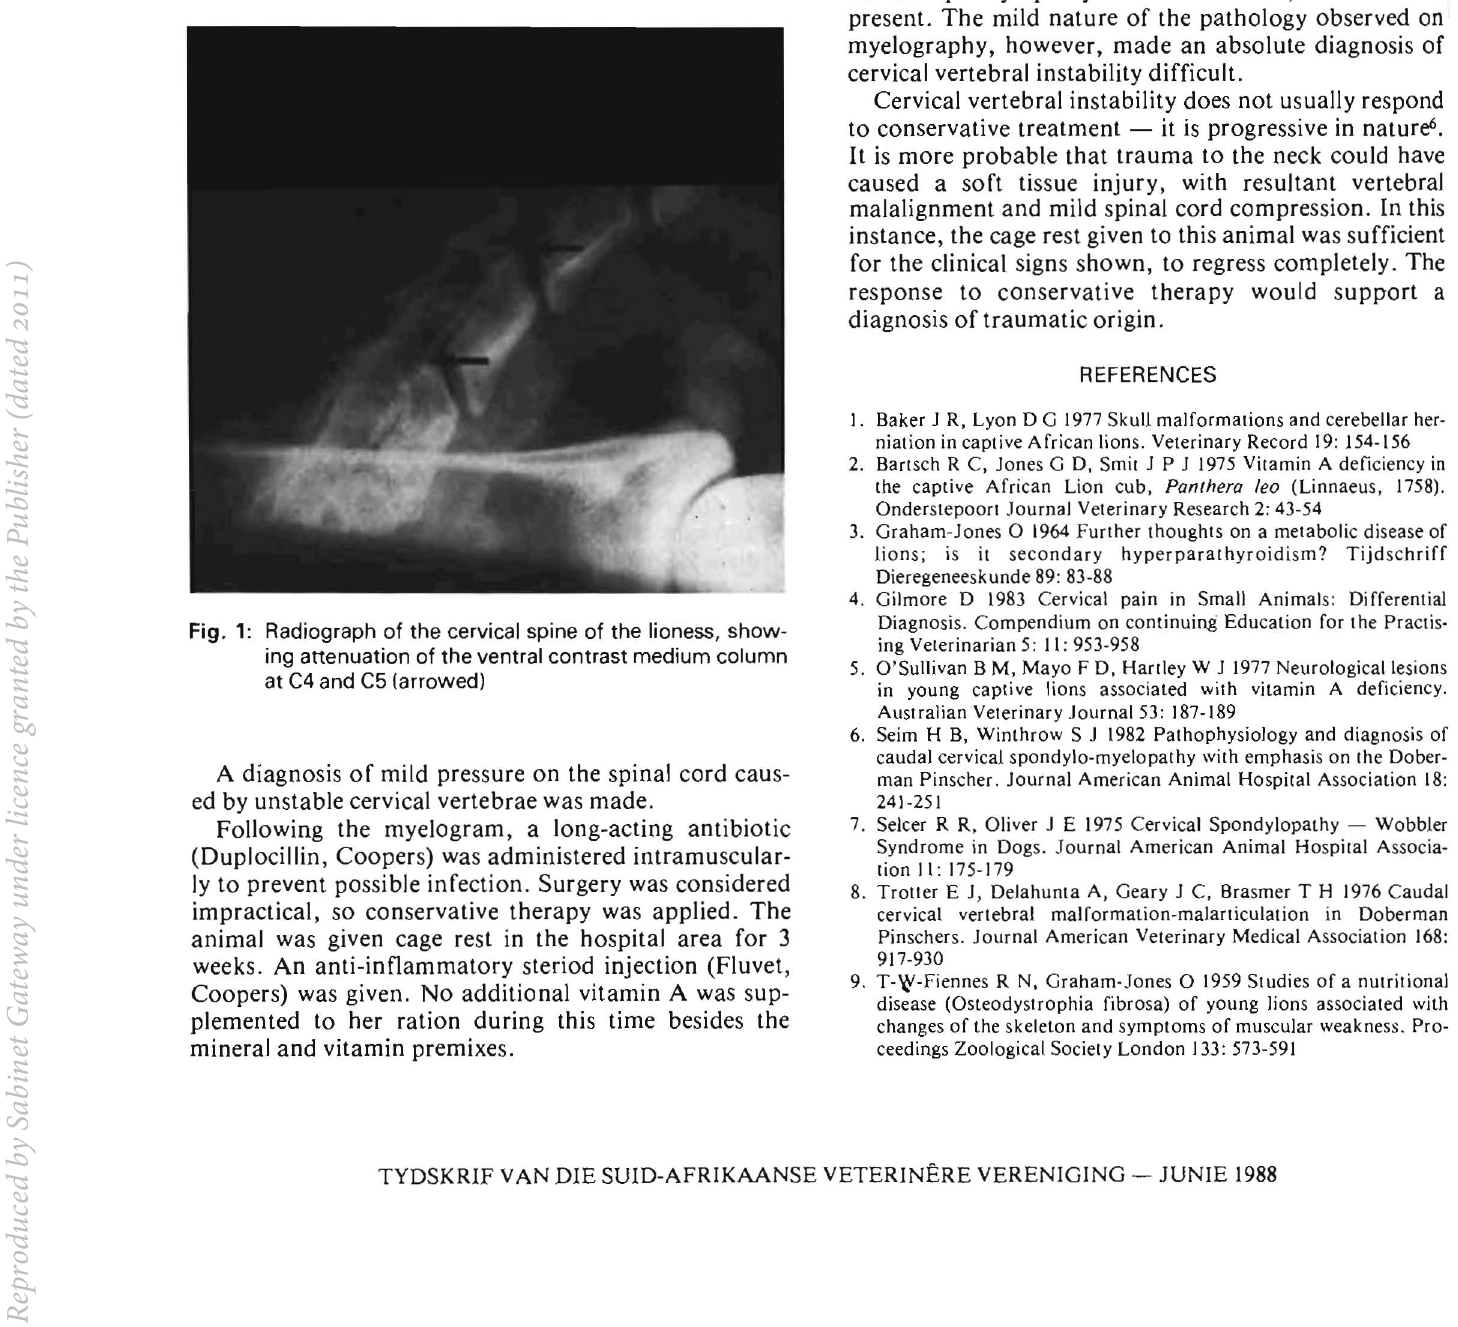
A diagnosis of mild pressure on the spinal cord caus ed by unstable cervical vertebrae was